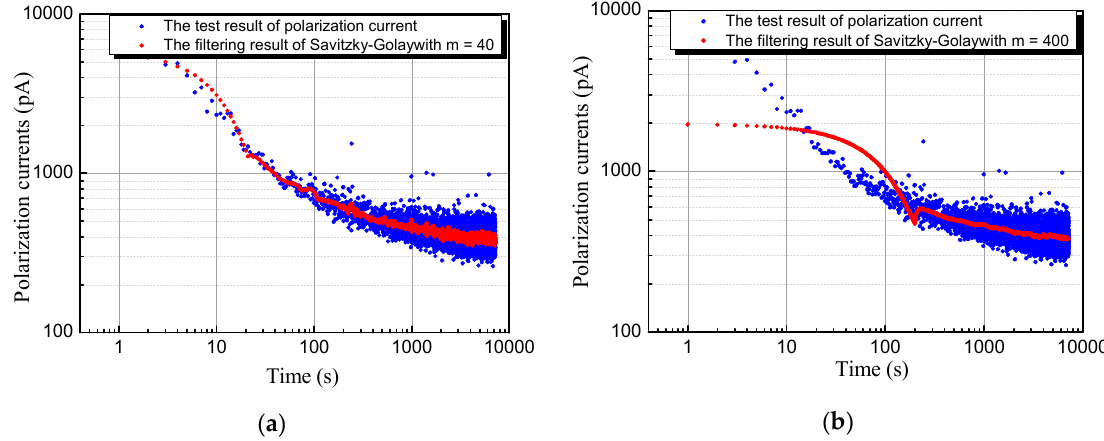
Figure 5. The e ff ect diagram Savitzky–Golay smooth filtering with di ff erent window widths: ( a ) The